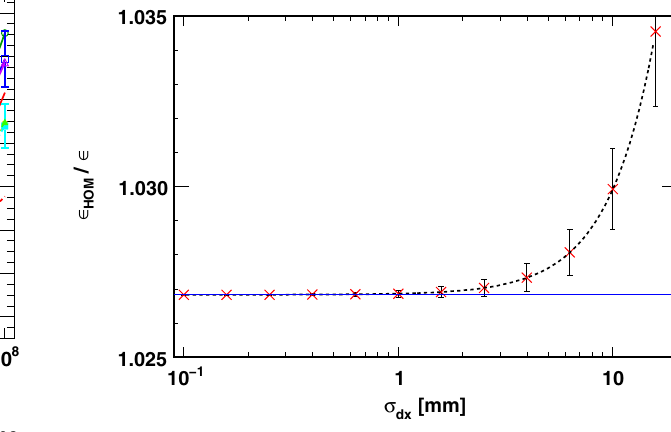
FIG. 32. Average transverse phase space increase against cav- ity alignment errors (red crosses with error bars). A second order polynomial is fitted through the data (dashed line). For compari- son the phase space increase without cavity displacement (blue line) is added. Settings: N ¼ 100 , see Table IX.